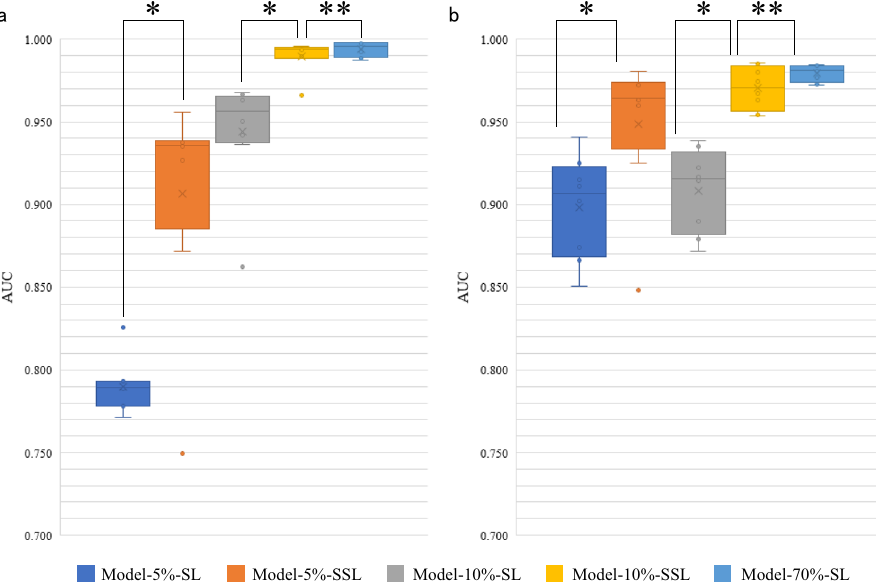
Fig. 2 Area under the curve (AUC) distribution of fi ve models at patch level. The boxes indicate the upper and lower quartile values, and the whiskers indicate the minima and maxima values. The horizontal bar in the box indicates the median, while the cross indicates the mean. The circles represent data points, and the scatter dots indicate outliers. * indicates signi fi cant difference, and ** indicates no signi fi cant difference. a The evaluation of fi ve models on the testing set of Dataset-PATT. Eight versions of each model (number of experiments per model = 8) are tested at their testing sets (number of samples/ patches per testing set = ~18,819) independent from their training sets, respectively. The Wilcoxon-signed rank test is then used to evaluate the signi fi cant difference of AUCs (sample size/group = 8) between two models. Two-sided P values are reported, and no adjustment is made. The average AUC and standard deviation of Model-5%-SSL and Model-5%-SL: 0.906 ± 0.064 vs. 0.789± 0.016, P value = 0.017; Model-10%-SSL and Model-10%-SL: 0.990 ± 0.009 vs. 0.944 ± 0.032, P value = 0.012; Model-10%-SSL and Model-70%-SL: 0.990 ± 0.009 vs. 0.994 ± 0.004, P value = 0.327. b The evaluation of 8 versions of fi ve models on the Dataset-PAT (number of samples/patches per testing set = 100,000). Wilcoxon-signed rank test (sample size/group = 8), and two-sided P values are reported. Model-5%-SSL and Model-5%-SL: 0.948 ± 0.041 vs. 0.898 ± 0.029, P values = 0.017; Model-10%- SSL and Model-10%-SL: 0.970 ± 0.012 vs. 0.908 ± 0.024, P value = 0.012; Model-10%-SSL and Model-70%-SL: 0.970 ± 0.012 vs. 0.979 ± 0.005, P values = 0.263. The AUC values of each model on Dataset-PATT and Dataset-PAT are combined and the Wilcoxon-signed rank test is performed on the combined results (sample size/group = 16), and two-sided P values are reported. Model-5%-SSL and Model-5%-SL: 0.927 ± 0.058 vs. 0.843 ± 0.059, P value = 0.002; Model-10%-SSL and Model-10%-SL: 0.980 ± 0.014 vs. 0.926 ± 0.034, P value = 0.0004; Model-10%-SSL and Model-70%-SL: 0.980 ± 0.014 vs. 0.987 ± 0.008, P value =